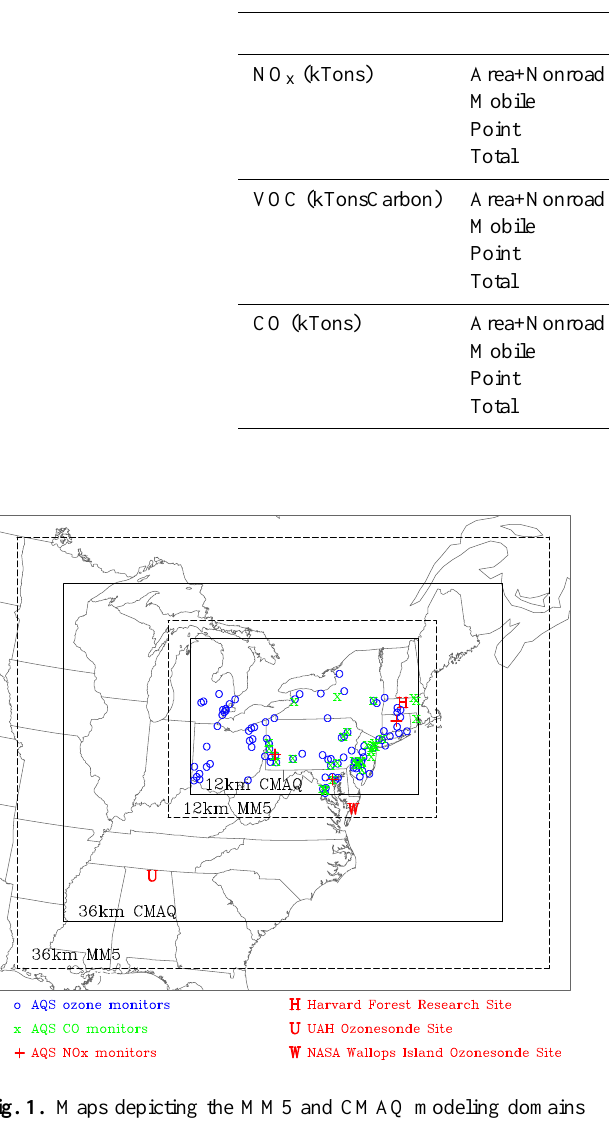
Table 1. Summary of domain-total anthropogenic emissions for different source sectors for 1990, 1995, 2000, and 2005.